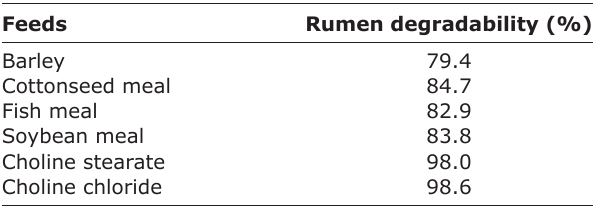
Table-1: Rumen degradability of dietary feed choline and synthetic choline